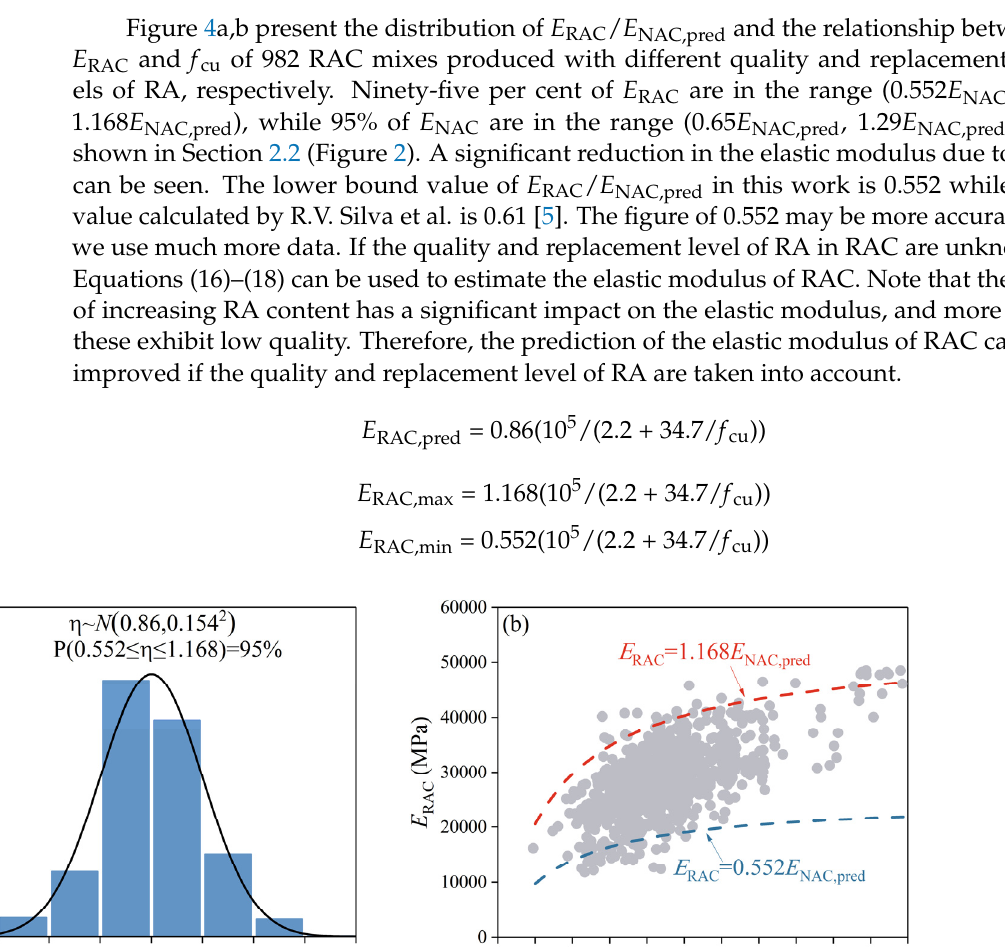
Figure 4. Distribution of η and E RAC [21,22,28–167,169–174]. ( a ) η ~ N (0.86,0.154 2 ); ( b ) 1.168 E NAC,pred ≥ E RAC ≥ 0.552 E NAC,pred .